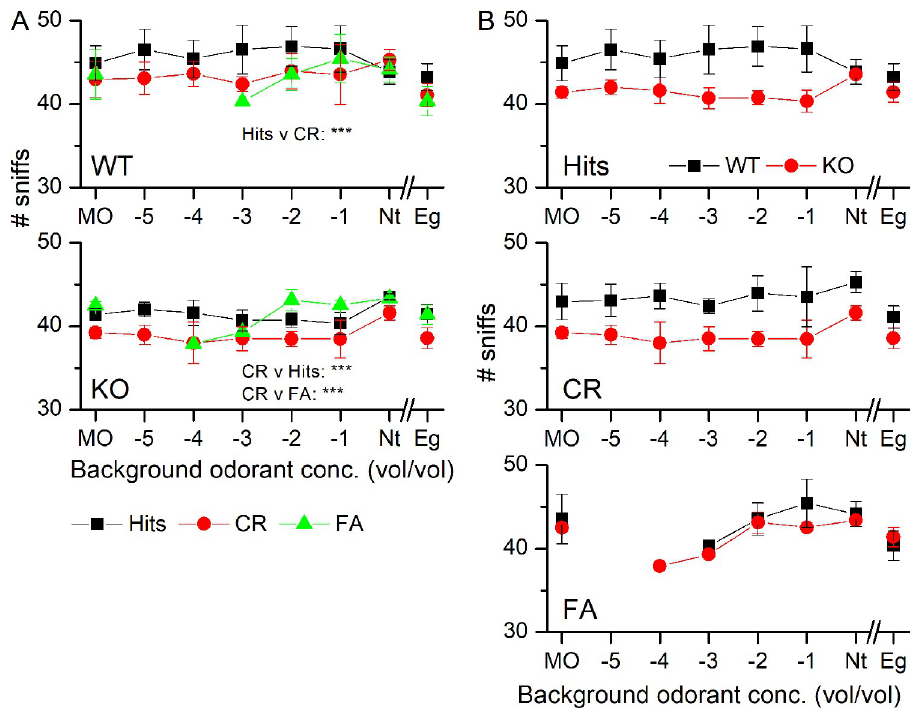
Fig 10. Number of sniffs taken in the presence of background odorants. A Comparison of the total number of sniffs taken during the five 200 ms bins centered on 0.5 to 1.3 s in WT (top) and NCKX4 KO (bottom) mice for Hits, CRs and FAs in dependence of the background odorant. B Comparison of Hits, CRs and FAs between the WT and the KO. The number of taken sniffs has a significant interaction between behavioral outcome and genotype (F = 4.4262, p = 0.014). Post-hoc comparisons (Tukey) show that while in the WT CR are different only from Hits (p = 0.0084), in the KO CR are different from FA (p = 0.0001) and Hits (p = 0.0002). No significant differences are detected between WT and KO. Repeated measures ANOVA. Nt versus Eg show are overall different (F = 9.727, p = 0.036). Data points are average ± SEM of 3 WT and 4 KO mice. The x-axis displays the log of the odorant